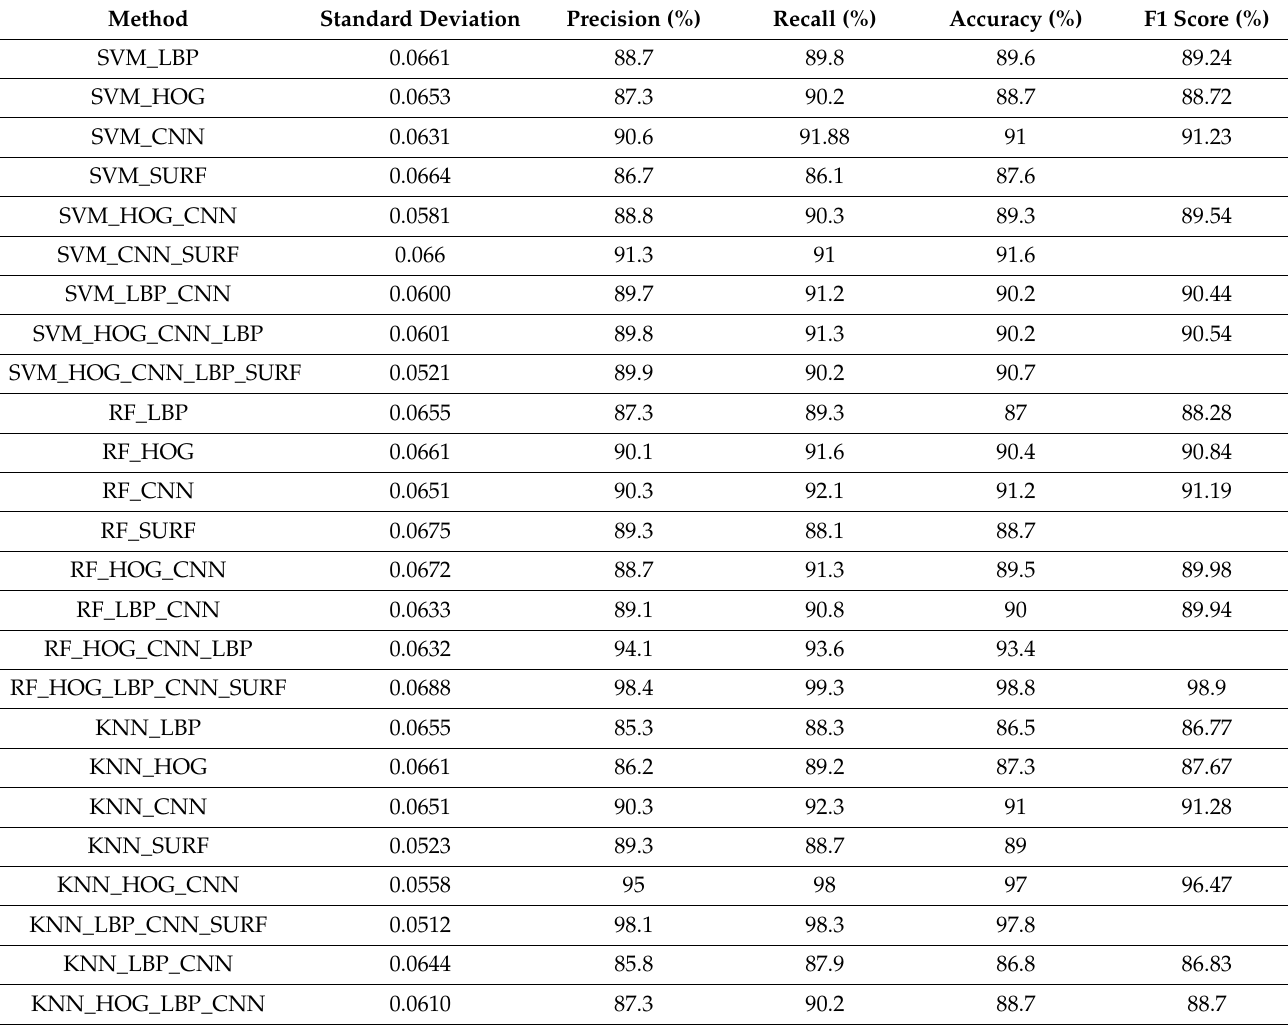
Table 5. Performance of the Proposed Algorithms upon